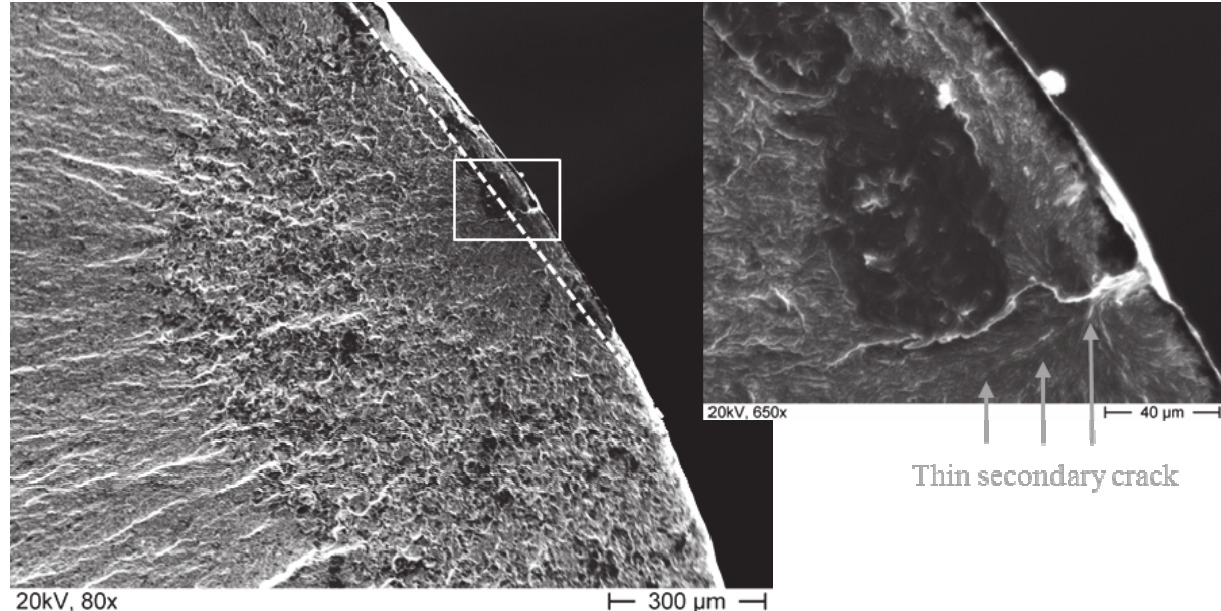
Figure 2: Fracture surface of an in-phase specimen tested in air. The approximate position of the metallographic section in Fig. 4 is indicated by the dashed